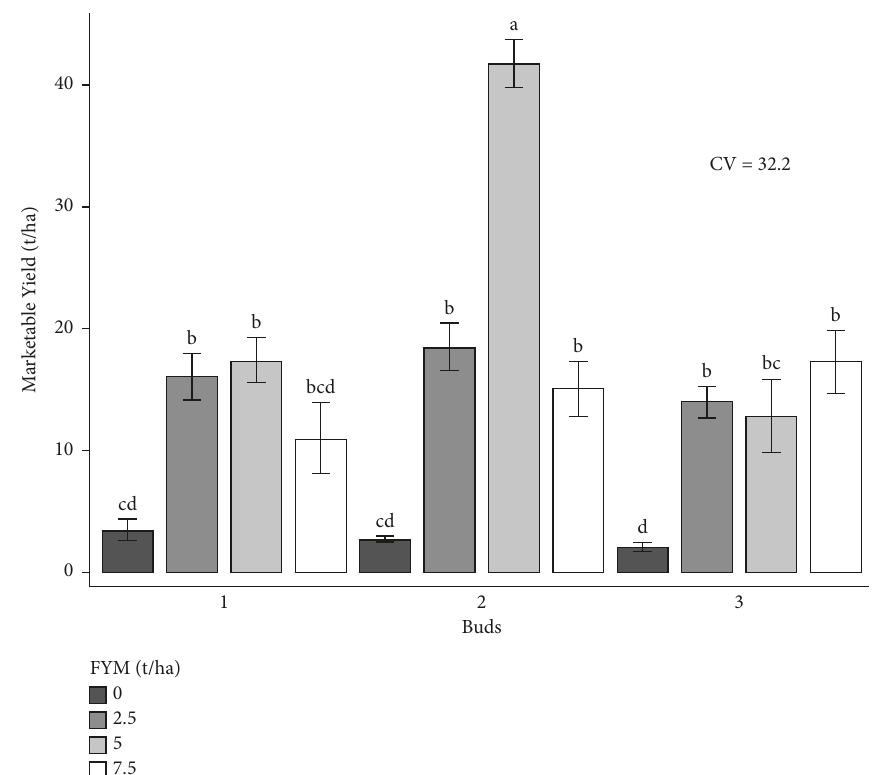
Figure 4: Marketable yield as influenced by the interaction effect of bud numbers and farmyard manure fertilizer rates.